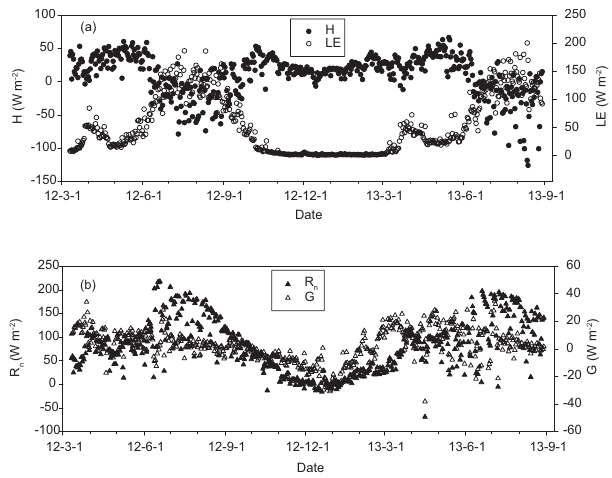
Figure 5. Slope, intercept and r 2 of the half-hourly energy balance closure.